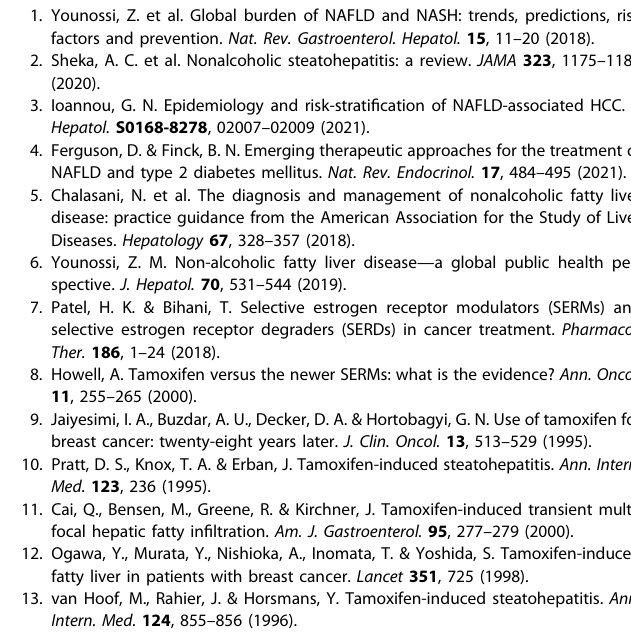
Fig. 7 Pharmacological activation of JNK/MAPK signaling pathway partly abolished the therapeutic effect of tamoxifen. a Dosing scheme of tamoxifen coupled with JNK activator-anisomycin (ANI) on male C57BL/6 mice fed with MCD diets for 6 weeks. Dose of tamoxifen: 100 mg/kg. Dose of anisomycin: 50 mg/kg. b Total protein was extracted from liver tissues in mice administrated with vehicle, ANI, tamoxifen or tamoxifen + ANI. Protein levels of JNK and p-JNK were determined by western blotting and quantitatively compared. c Serum analysis of ALT, AST, TC, TG, and HDL in mice administrated with vehicle, tamoxifen or tamoxifen + ANI. d Liver sections from MCD diets-induced mice administrated with vehicle, tamoxifen, or tamoxifen + ANI were performed H&E and ORO staining. Scale bar:100 μ m. e H&E fat cavitation area and ORO staining area were quantitatively compared. f Hepatic TG levels were measured and normalized by protein levels. g AML12 cells were stimulated by 0.3 mM PA and treated with 40 μ M tamoxifen. 10 μ M anisomycin or DMSO was added 2 h before tamoxifen treatment. ORO staining was performed. Scale bar: 100 μ m. h Cellular TG contents were measured and quantitatively compared. i Total proteins were extracted from AML12 cells treated with DMSO/ ANI/ tamoxifen/ tamoxifen + ANI. Protein levels of JNK and p-JNK were determined by western blotting. j The ratio of p-JNK/JNK and p-JNK/GAPDH were quantitatively compared. k AML12 cells were stimulated by 0.3 mM PA and treated with 40 μ M tamoxifen. 30 μ M CC930 or DMSO were added 2 h before tamoxifen treatment. ORO staining was performed. Scale bar: 100 μ m. l Cellular TG contents were measured and quantitatively compared. m Total proteins were extracted from AML12 cells treated with DMSO/ tamoxifen/CC930/tamoxifen + CC930. Protein levels of JNK and p-JNK were determined by western blotting. n The ratio of p-JNK/JNK and p- JNK/GAPDH were quantitatively compared. Bars = means ± SD; n = 3 – 6; ns, no signi fi cance; * P < 0.05; ** P < 0.01; *** P < 0.001; **** P <